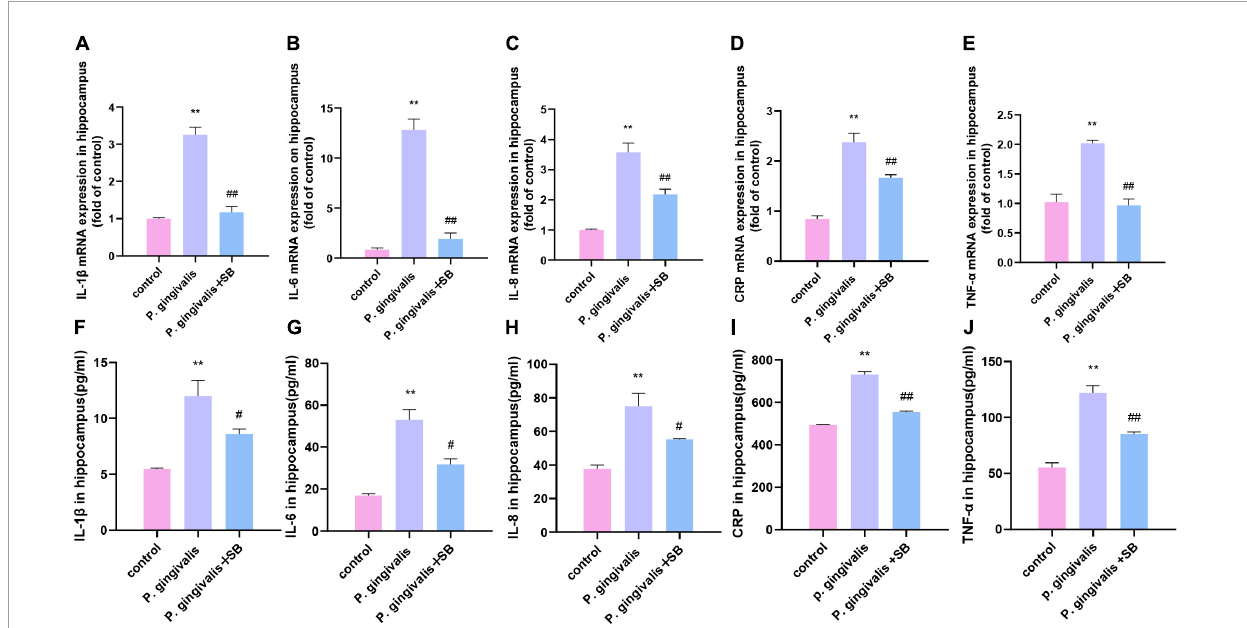
FIGURE7 Effects of periodontal inflammation in the hippocampus. q-PCR and ELISA were performed to detect the mRNA and protein levels of inflammatory cytokines in the hippocampus. The mRNA levels of cytokines in the hippocampus in each group: (A) IL-1 β ; (B) IL-6; (C) IL-8; (D) CRP; and (E) TNF- α . The protein levels of cytokines in the hippocampus in each group: (F) IL-1 β ; (G) IL-6; (H) IL-8; (I) CRP; and (J) TNF- α . Experimental values are expressed as the mean ± SEM ( n = 4 per group). ** p < 0.01 compared with the control group, # p < 0.05 and ## p < 0.01 compared with the P. gingivalis group.